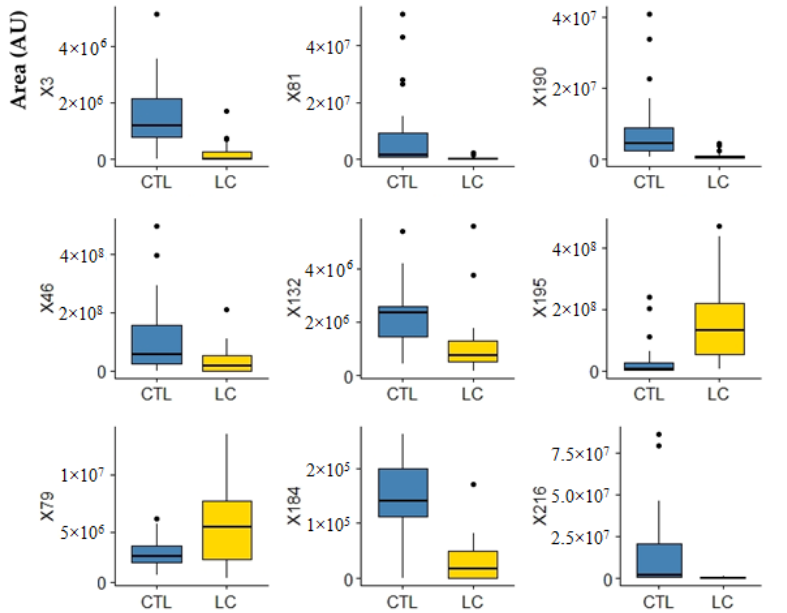
Figure 5. Boxplots of the most important variables (uVOMS) for the discrimination of LC patients from control subjects (CTRL). Legend: AU—arbitrary units; CTRL—control group; LC—lung can- cer; X3—furan; X46—o-cymene; X79—furfural; X81—linalool oxide; X132—viridiflorene; X184—2- bromophenol; X190—tricyclazole; X195—p-cresol; X216—1-(4-hydroxy-3,5-di-tert-butylphenyl)-2-